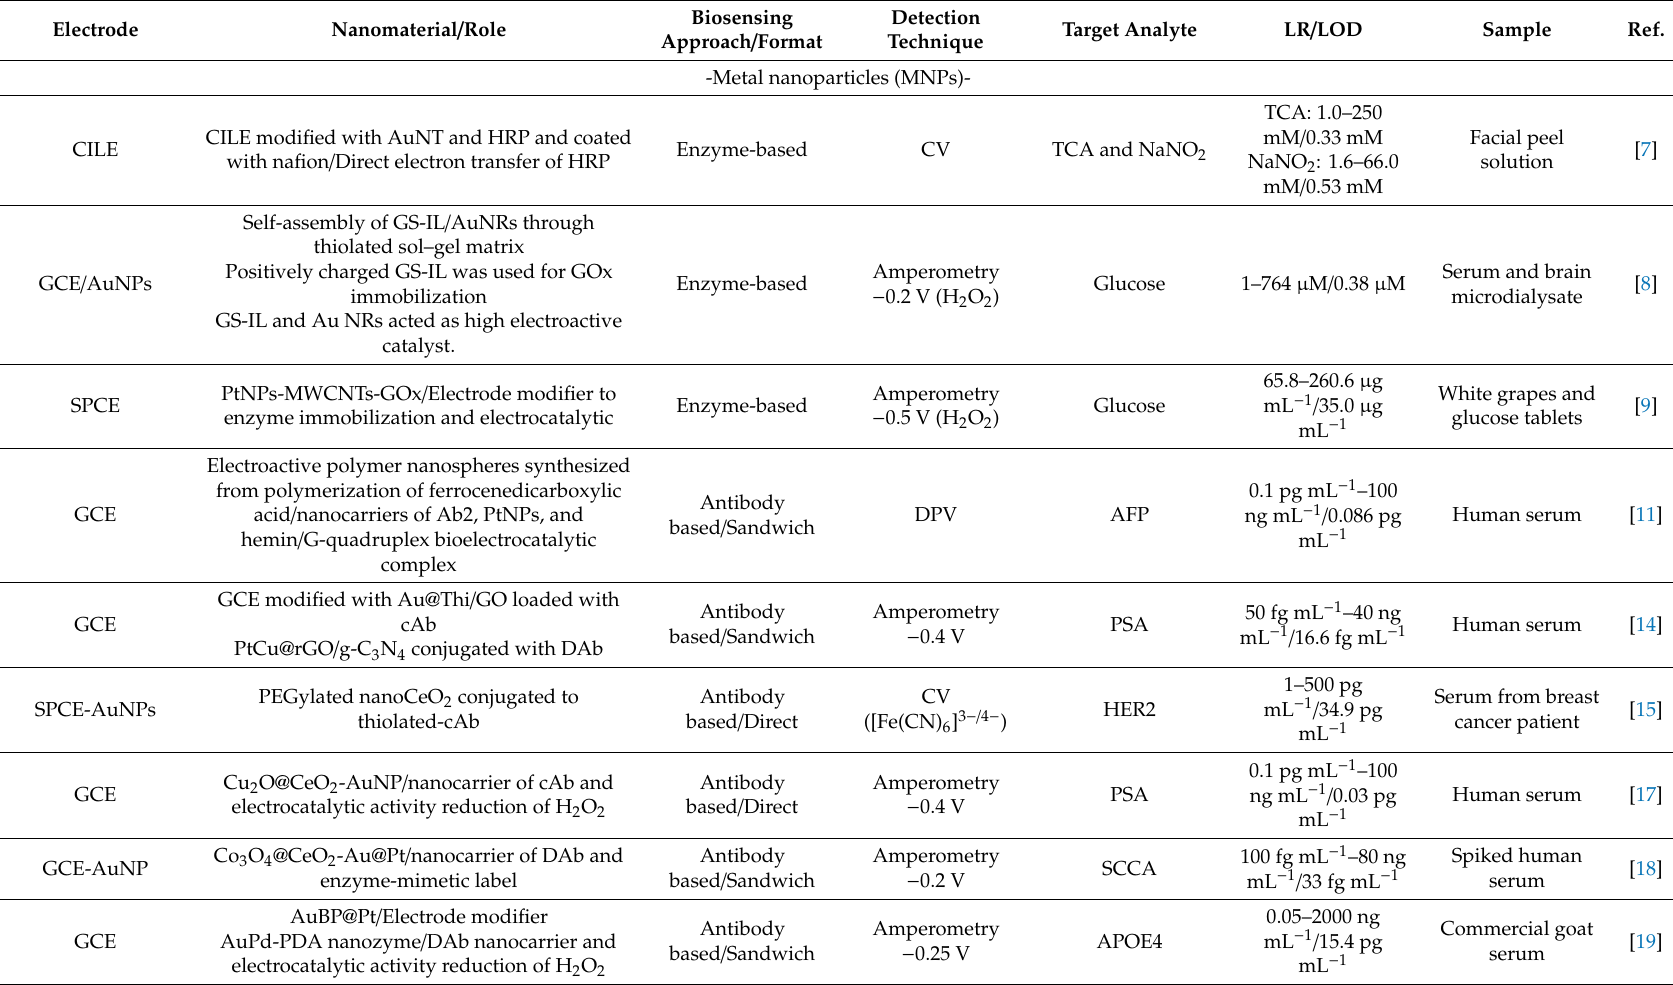
Table 1. Electrochemical biosensing methods involving multifunctional metal-based